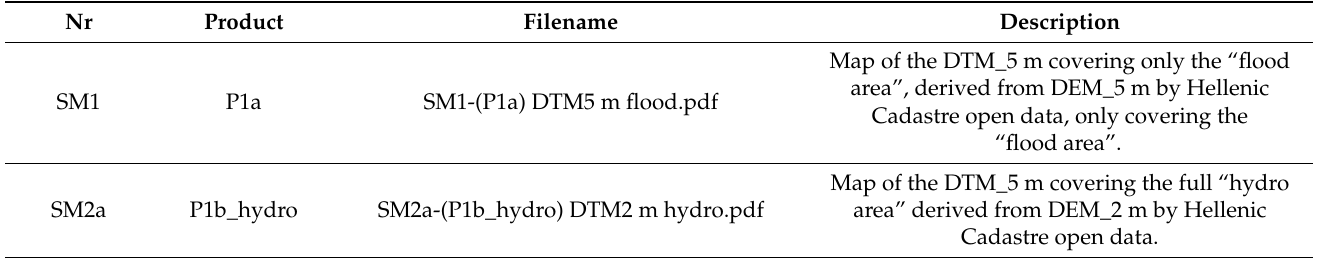
Table A1. List of Appendix A and relevant